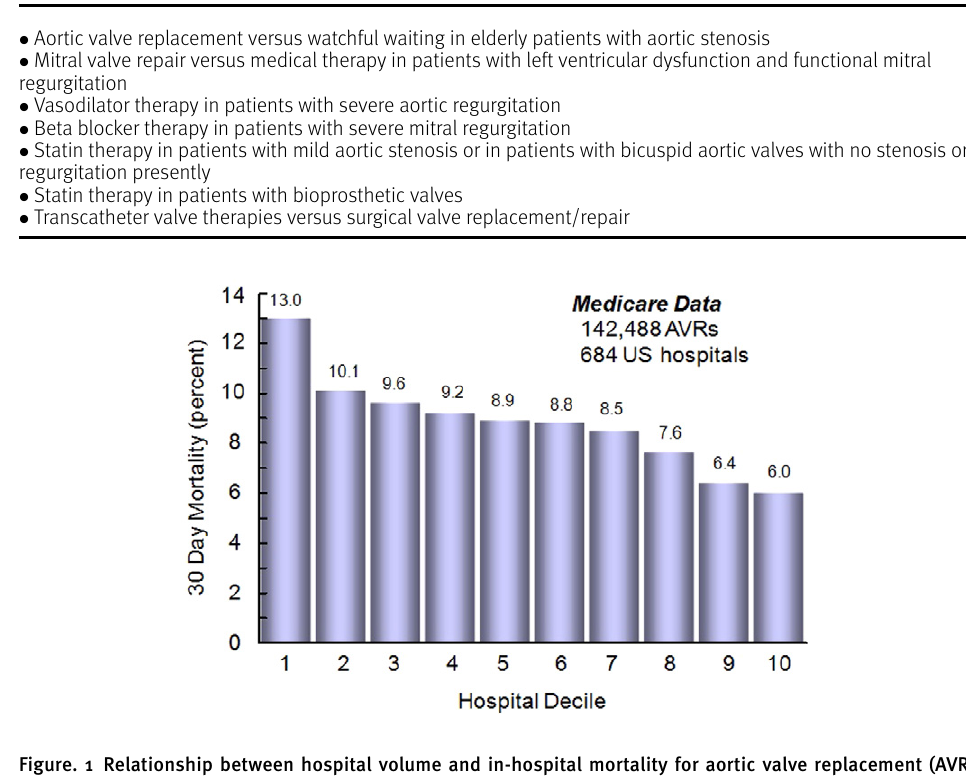
Candidate Topics for Prospective Randomized Trials in Valvular Heart Disease.